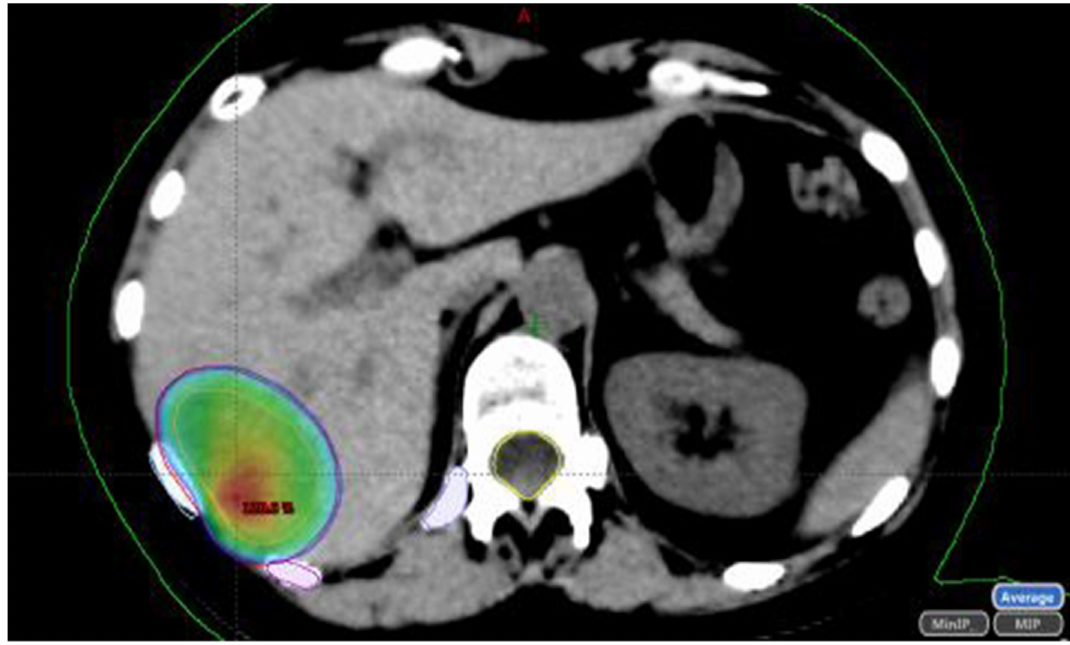
Figure 2. Liver metastases from CRC. Planning treatment. Dose: 55 Gy in 5 fractions. DBE: 116 Gy.